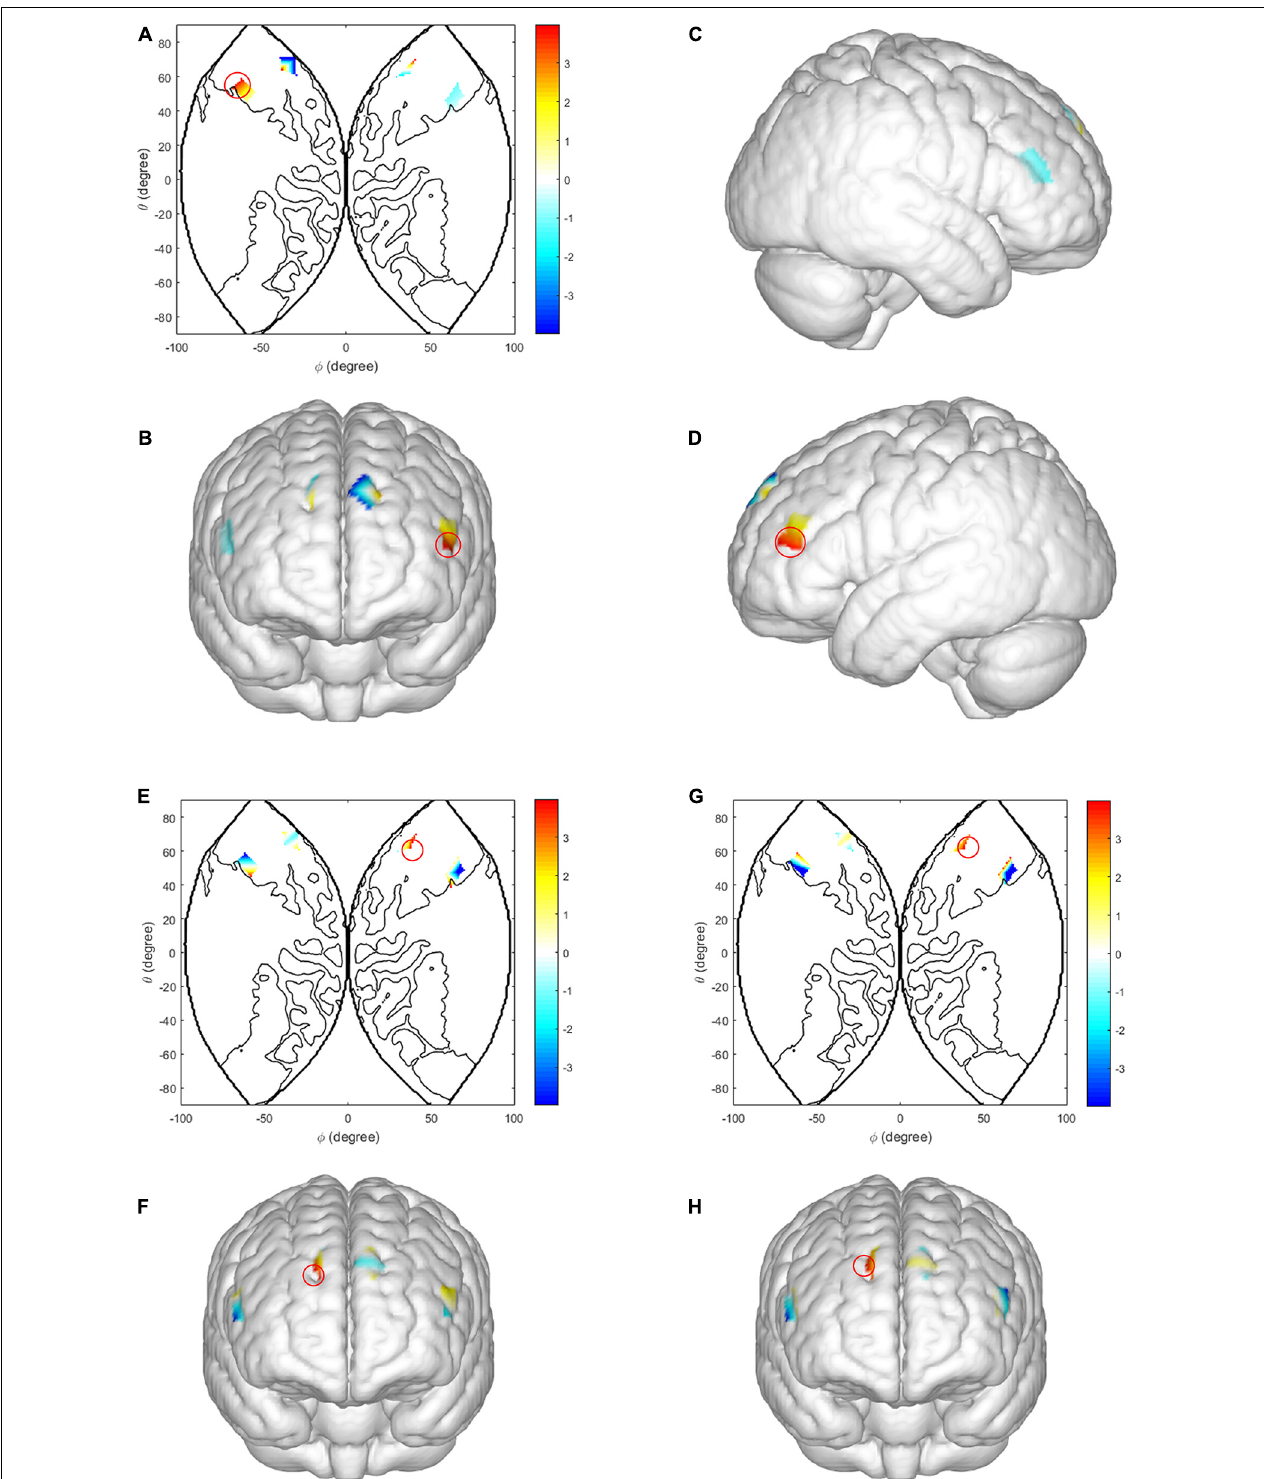
FIGURE 3 | Intra-brain activation in ISDM stage. (A–D) Higher activations in the left IFG (LIR condition vs. HIR condition). (A) The 2D model of activation map of the left IFG; (B) front, (C) right, and (D) left view of a 3D model of activation map of the left IFG. (E,F) Higher activations in the DLPFC and the middle frontopolar area of males (LIR condition vs. HIR condition, when male dyads made defection decision). (G,H) Higher activations in the DLPFC and the middle frontopolar area of males (cooperation decision vs. defection decision under HIR condition). Color bar indicated the pared-samples T -test value, the red circle represents the statistical significance areas, similarly